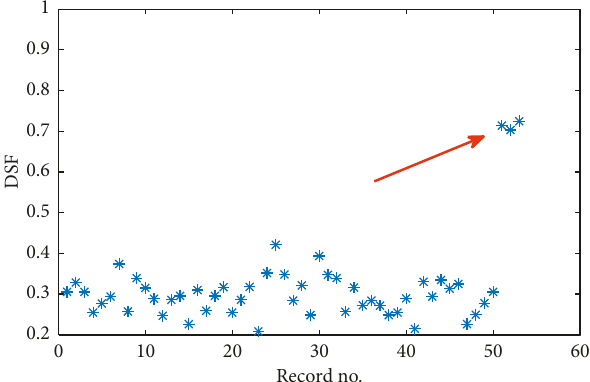
Figure 7: DSF obtained from object with limited data after ex- traction (reproduced from [24], under the Creative Commons Attribution-NonCommercial 4.0 International